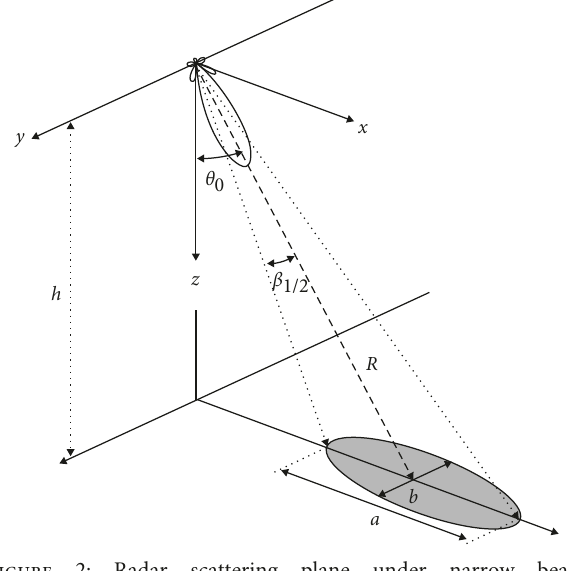
Figure 2: Radar scattering plane under narrow beam approximation.